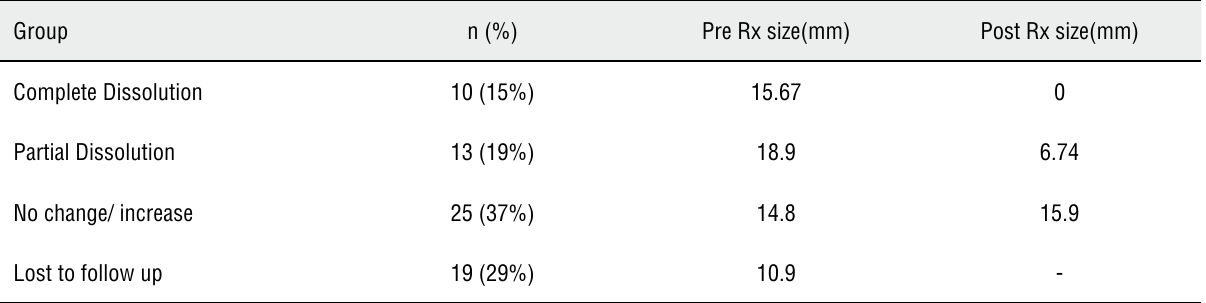
Table 1 - Dissolution rates and stone sizes before and after treatment in each group.